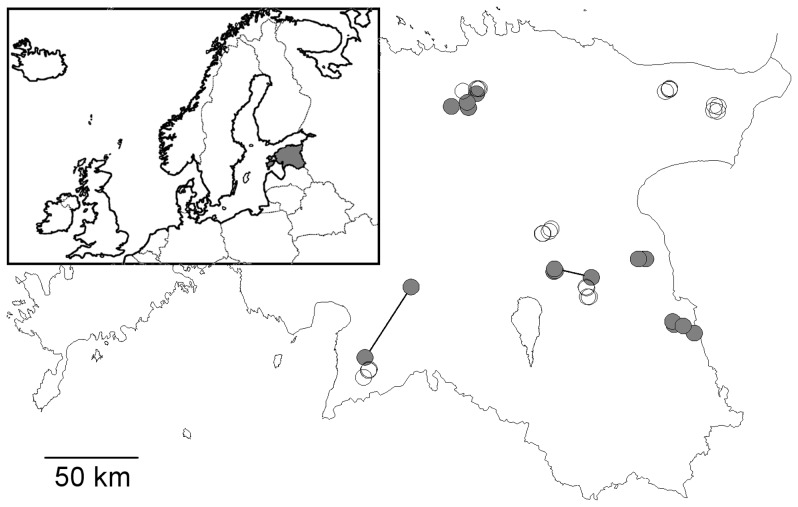
Locations of the study plots in Estonia.Filled circles–natural swamps, empty circles–drained sites. Each cluster of plots of similar type contains four differently managed plots (a ‘block’ of treatments) typically <10 km from each other; the connecting lines indicate two swamp ‘blocks’ where cutover plots were located farther away.